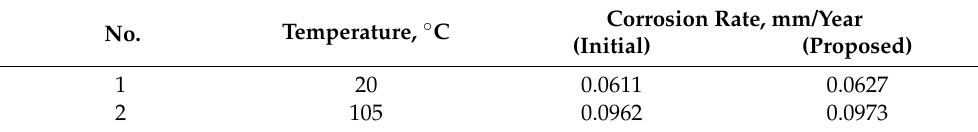
Table 5. The corrosion rate of polymer compositions.